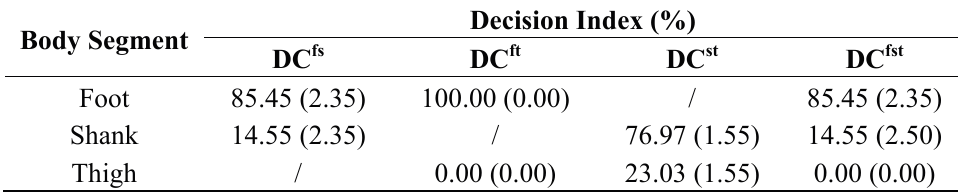
Table 2. Means, standard deviations of Decision Index for all of combinations of Distributed Classifier (DC).